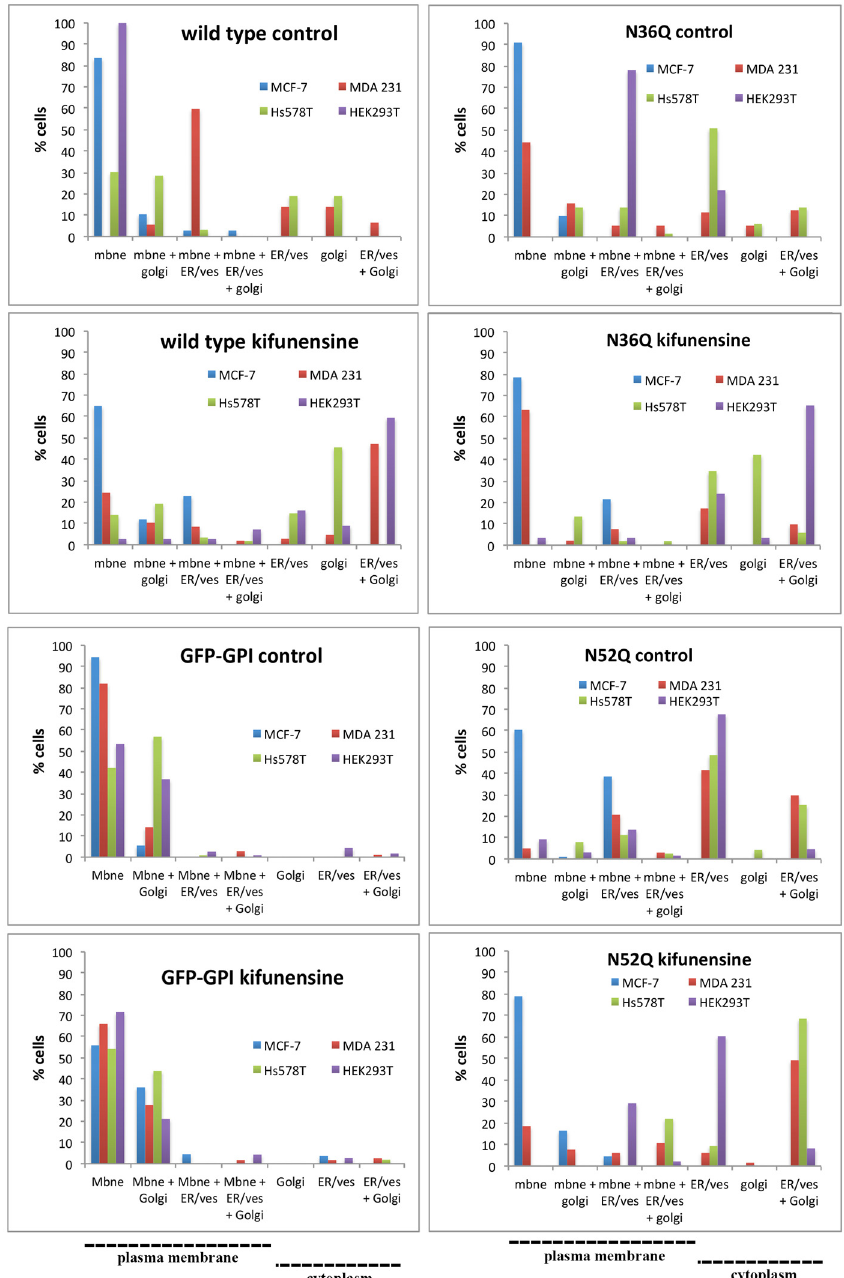
Figure 5. Effect of kifunensine on the subcellular localization of CD24. Cells transfected for 48 h with wild type, N36Q or N52Q CD24 in presence or absence of kifunensine. Then, cells were im- munolabeled with anti-flag and anti-GM130 antibodies and subcellular localization of CD24 was analyzed using confocal microscopy. As a control, cells were also transfected with GFP-GPI and subcellular localization was assessed with anti-GFP and anti-GM130 immunolabelling. Seven dis- tinct cell phenotypes were analyzed for each cell line/construct/treatment as follows: (1) cells with only plasma membrane staining (mbne); (2) cells with plasma membrane plus golgi staining (mbne + golgi); (3) cells with plasma membrane plus ER or vesicular staining (mbne + ER/ves); (4) cells with plasma membrane plus ER or vesicular plus golgi staining (mbne + ER/ves + golgi); (5) cells with only ER or vesicular staining (ER/ves); (6) cells with only golgi staining (golgi); (7) cells with ER or vesicular plus golgi staining (ER/ves + golgi). Sum of cells with phenotypes 1, 2, 3 and 4, or 5, 6 and 7 constitute group of cells with plasma membrane or cytoplasmic CD24, respectively. Statis- tical analysis of different phenotypes is presented in Figure S5 and Table S3.